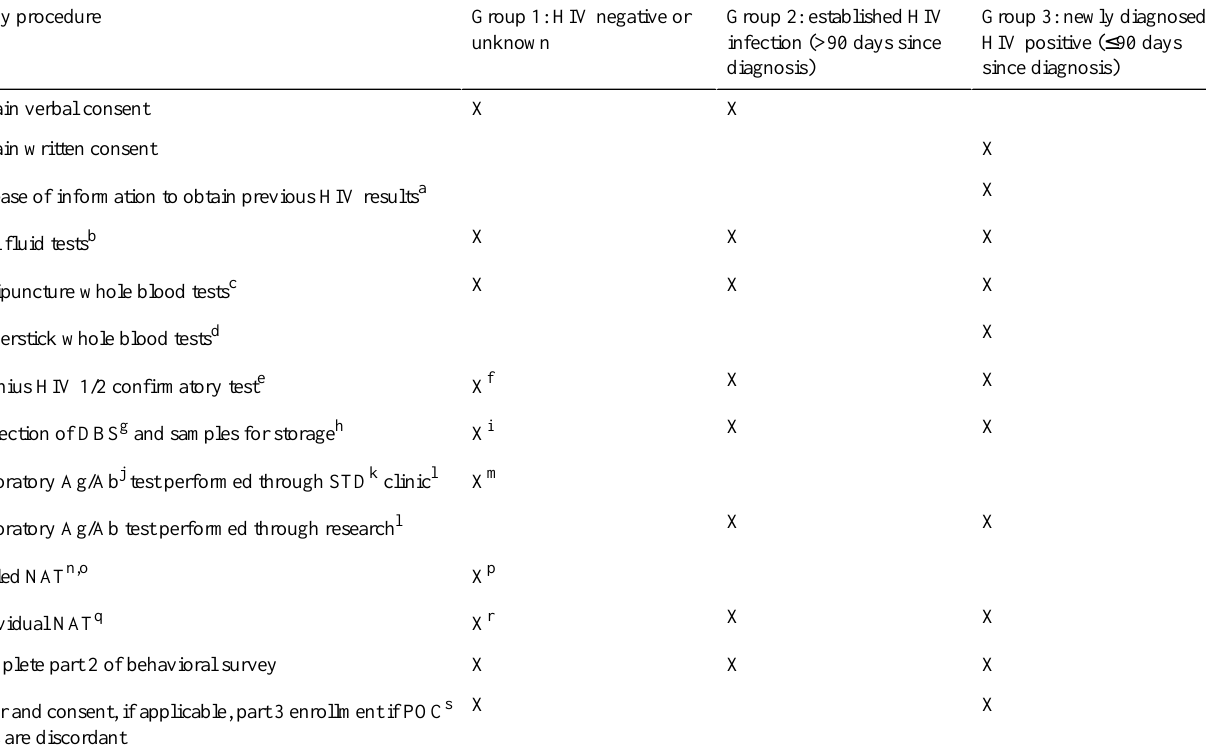
Table 1. Project DETECT part 2 procedures.